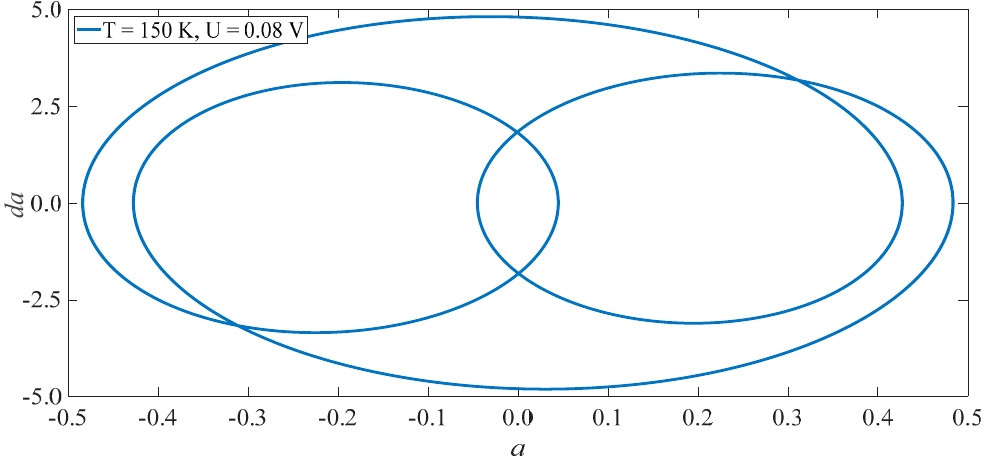
Figure 17. Numerical solution of the second mode with ( c 2 , f 2 , σ ) = ( 5,40,80 ) .